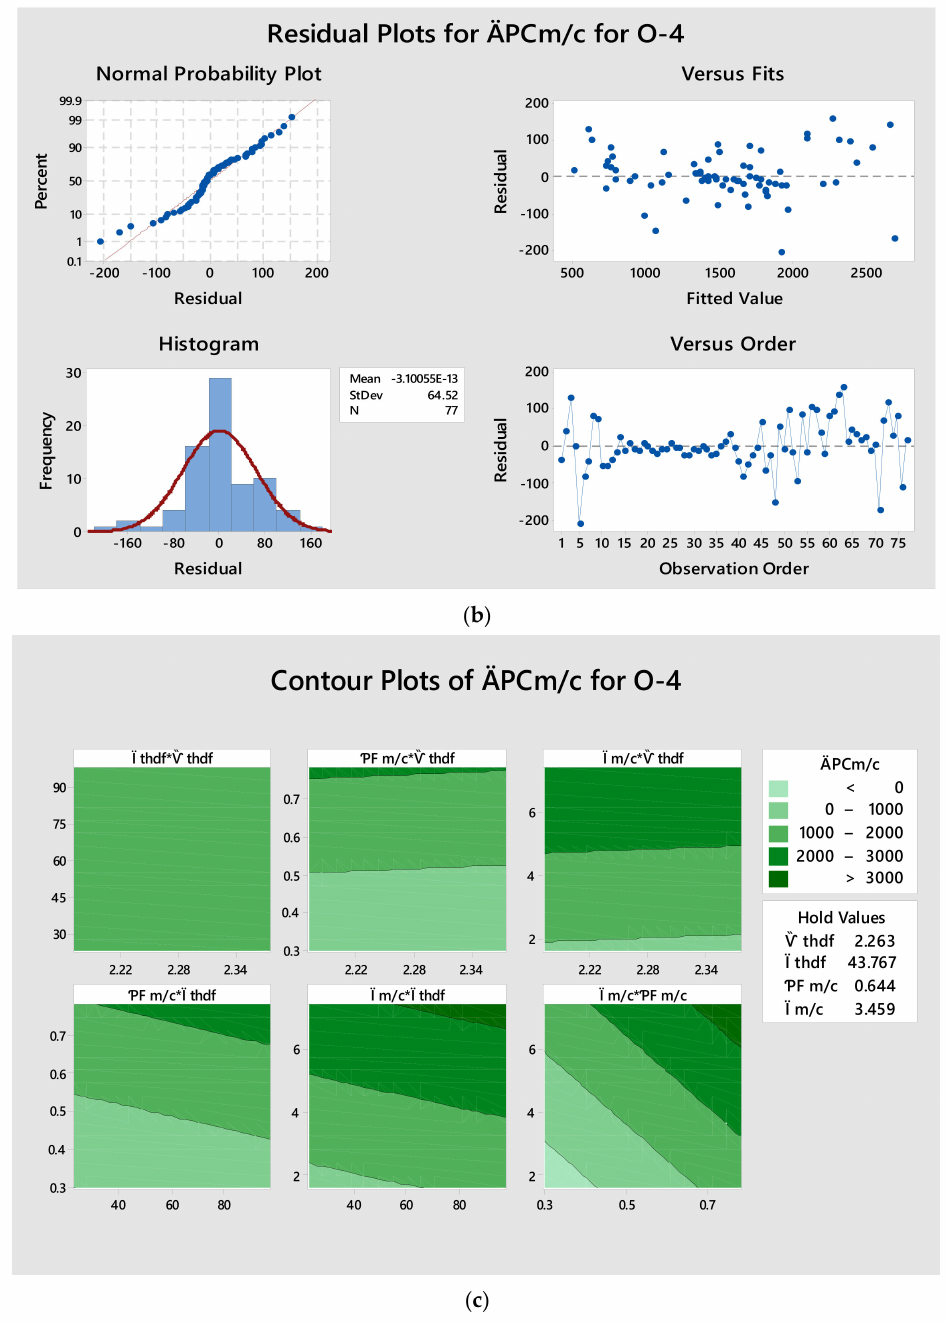
Figure 7. ( a ) Main effects plot for O-4. ( b ) Residuals plot for O-4. ( c ) Contour plots for